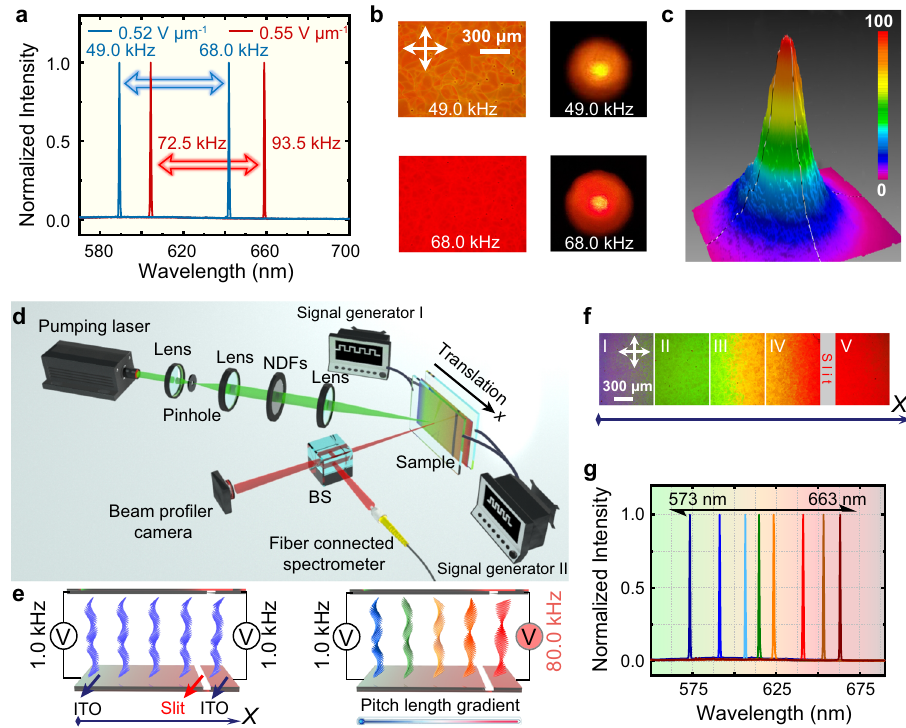
Fig. 5 Dynamic tunable laser emission in heliconical LC through the frequency of the electric fi eld. a Laser emission spectra from the heliconical superstructure. b Corresponding POM textures (left) and laser emission spots (right). c Gaussian distribution of the laser emission intensity pro fi le. d Schematic diagram of the experimental setup for characterizing laser performance (see “ Methods ” ). Neural density fi lters (NDFs), Beam splitter (BS). e Two independent electric fi eld signals were applied to the specially designed sample with signal generators I and II. The upper and lower electrode layers (i.e., indium tin oxide, ITO) on the glass substrates of the sample were separated into two discrete regions with nonconductive slits. When the applied electric fi eld strengths and frequencies of the two regions were both the same (i.e., 0.50 V μ m − 1 , 1.0 kHz), the sample presented a uniform bluish re fl ection color. When the frequency of the electric fi eld was adjusted to 80.0 kHz on the right side while the frequency of the left side remained unchanged, the entire sample generated a temperature gradient distribution with a gradual, rainbow-like change in re fl ection colors from left to right. f The corresponding POM textures. g Laser emission spectra covering 573 to 663 nm, which could be modulated by translating the sample on the x -axis to generate the laser of the cell. Here, the cell gap was kept at 96 µ m thick for obtaining the preferable laser properties. Source data are provided as a Source Data fi